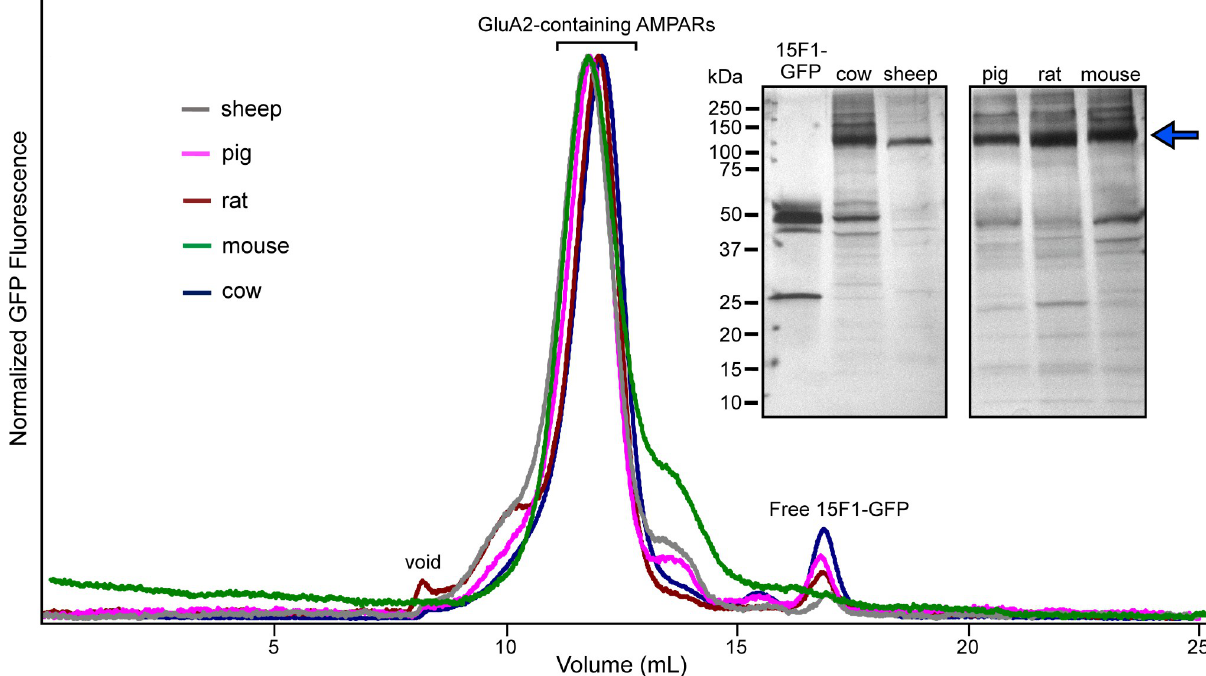
Fig 4. Analysis of purified native AMPARs. Overlaid FSEC profiles of 15F1 Fab-purified AMPAR assemblies from the five mammals. Inset: Silver- stained, SDS-PAGE analysis of purified receptors. The blue arrow indicates the migration position of the majority of the AMPAR subunits. The samples were run on two different gels and positioned adjacent to each other for